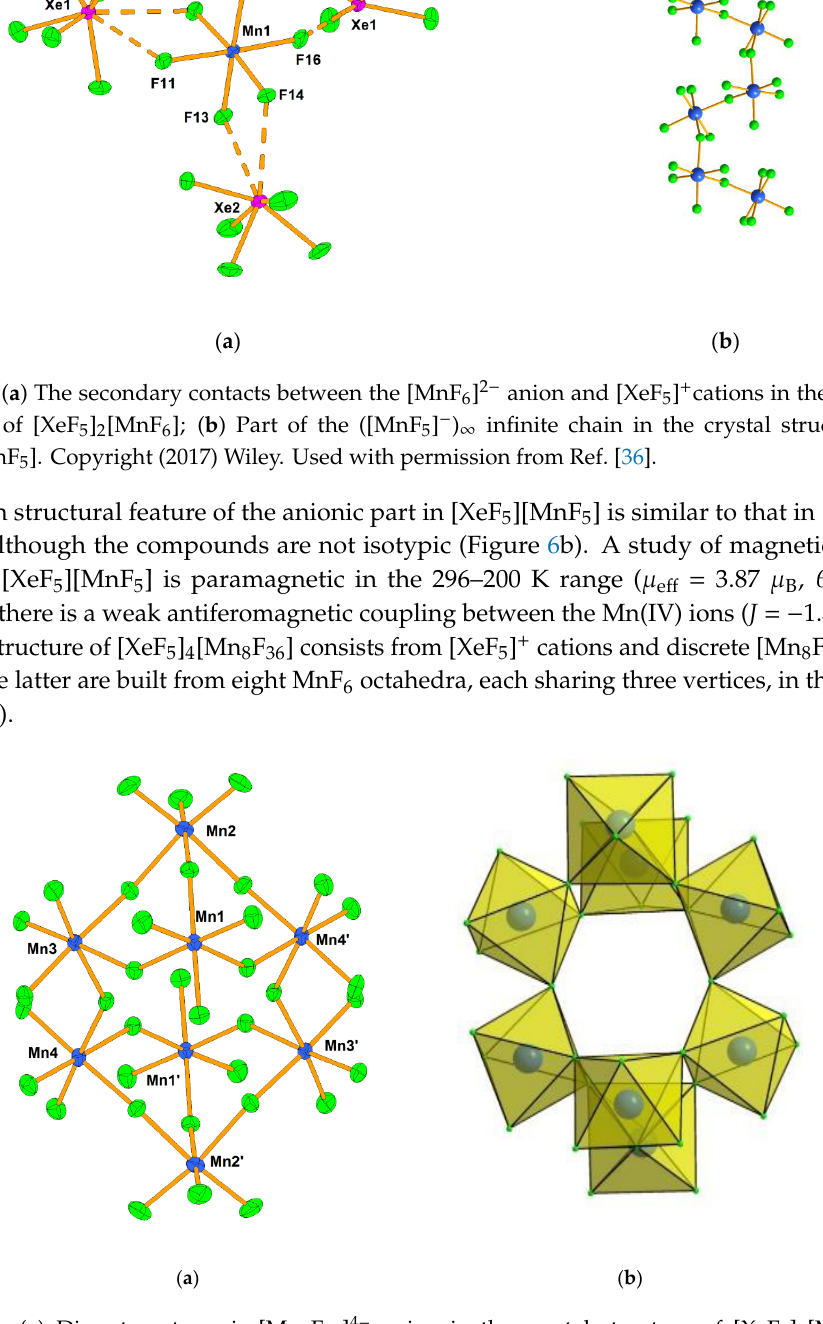
Figure 7. ( a ) Discrete octameric [Mn 8 F 36 ] 4 − anion in the crystal structure of [XeF 5 ] 4 [Mn 8 F 36 ]; ( b ) Geometry of the [Mn 8 F 36 ] 4 − anion built from eight MnF 6 octahedra. Copyright (2017) Wiley. Used with permission from Ref.